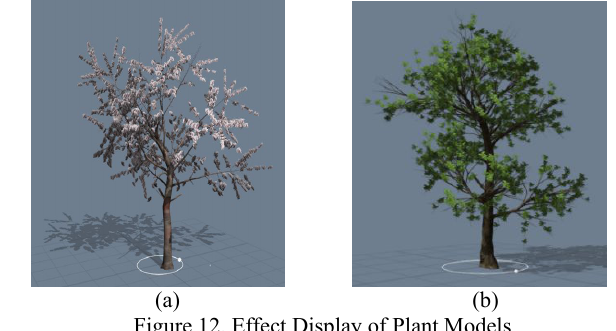
Figure 12. Effect Display of Plant